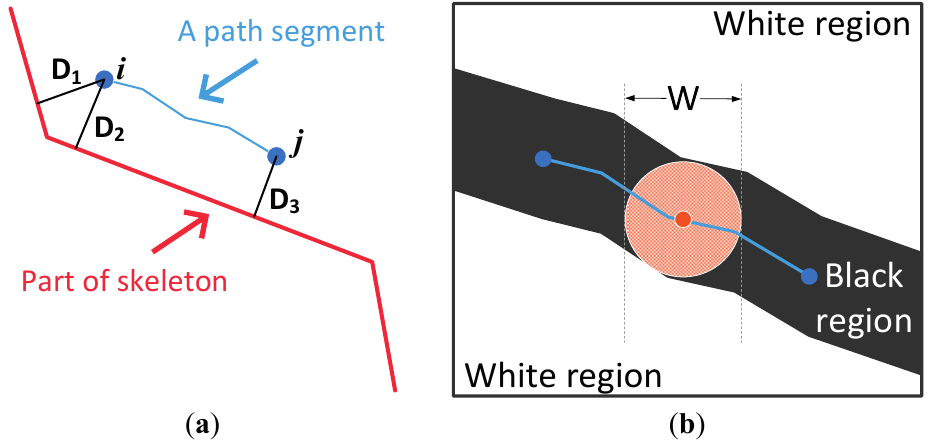
Figure 8. Calculation methods for (cid:1830)((cid:1861), (cid:1862)) and (cid:1849)((cid:1861), (cid:1862)) . ( a ) The red polyline is part of the skeleton. The blue polyline is a path segment, and the blue solid dots are nodes of the segment. ( b ) The white region is the higher area, and the black region is the lower area. The orange solid dot is the middle point of the path, and the light orange area is the dilated region of the middle point.